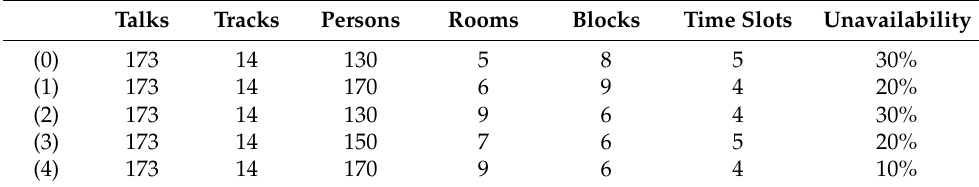
Table 2. Details of the training instances provided for the tuning process.